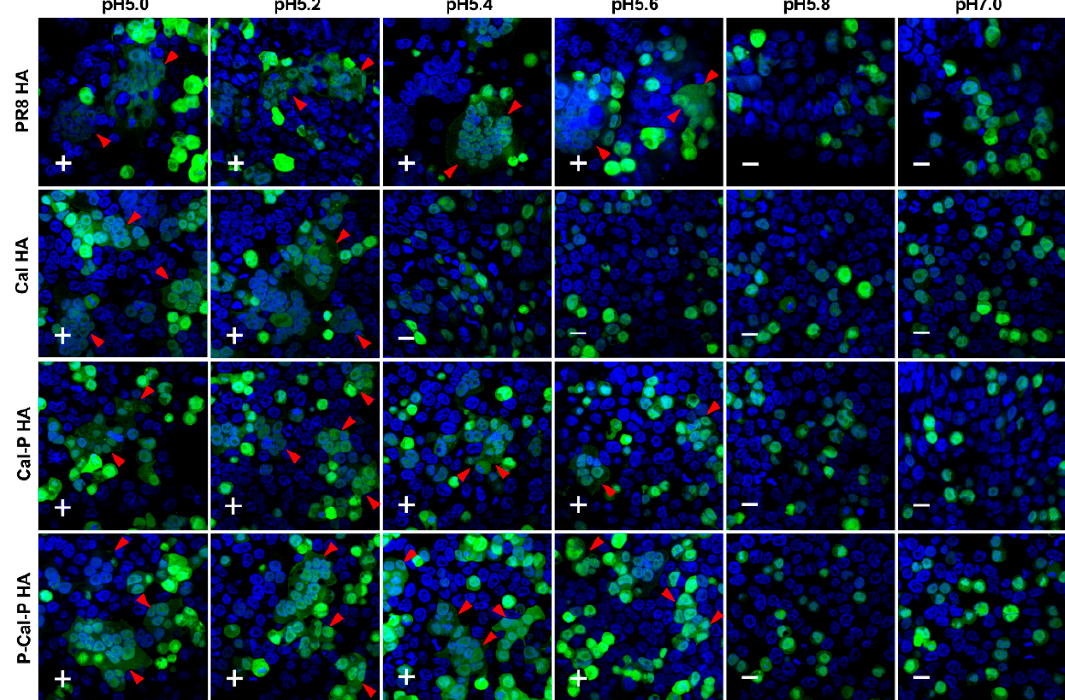
Figure 7. Cell membrane fusion of chimeric HA. 293T cells were cotransfected with HA and EGFP expression plasmids. The cells were treated with acetyl trypsin and subsequently, with buffers of pH 5.0–7.0. The cells were incubated at 37 °C for 2 h. After fixation with paraformaldehyde, cell nuclei were stained with DAPI. Arrowheads indicate cell fusion. +, cell fusion-positive; − , cell fusion-negative.